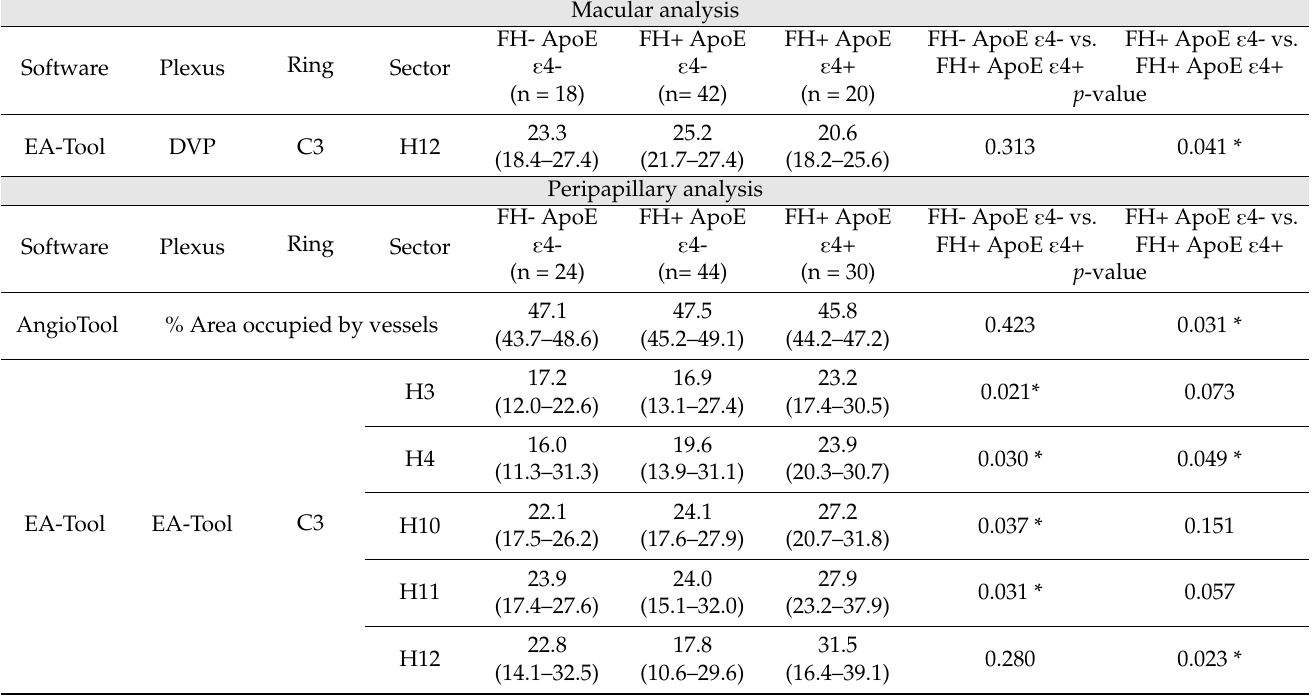
Table 1. The vascular analysis of significant data according to family history and the characterization of ApoE E